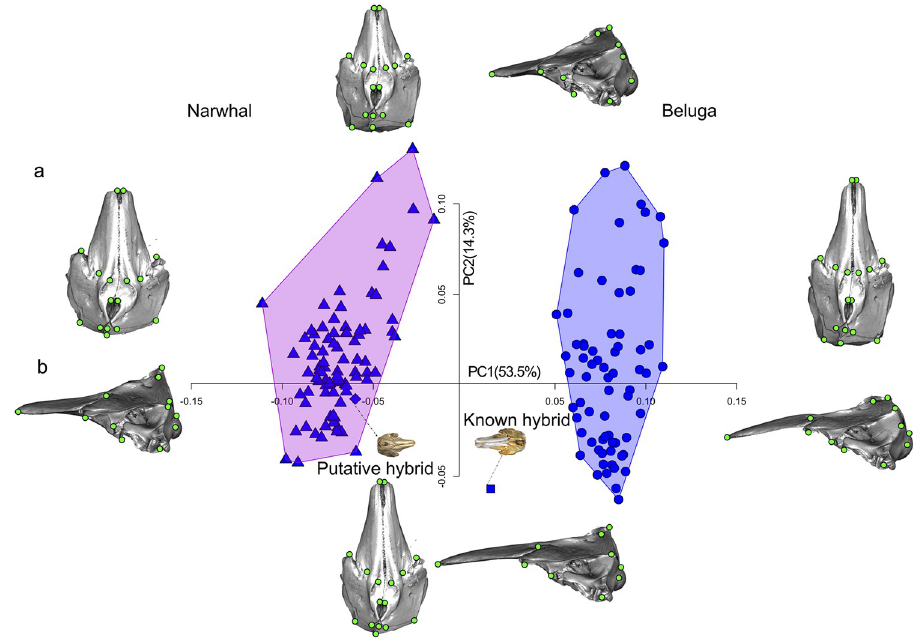
Fig 3. PCA on crania dataset with 40 landmarks. Principal Component (PC) plot of the cranial shape of the three- dimensional (3D) Monodontidae dataset with 40 landmarks. Shape differences along the axis of the PC1 and PC2 are visualized with warping in A) dorsal and B) left lateral